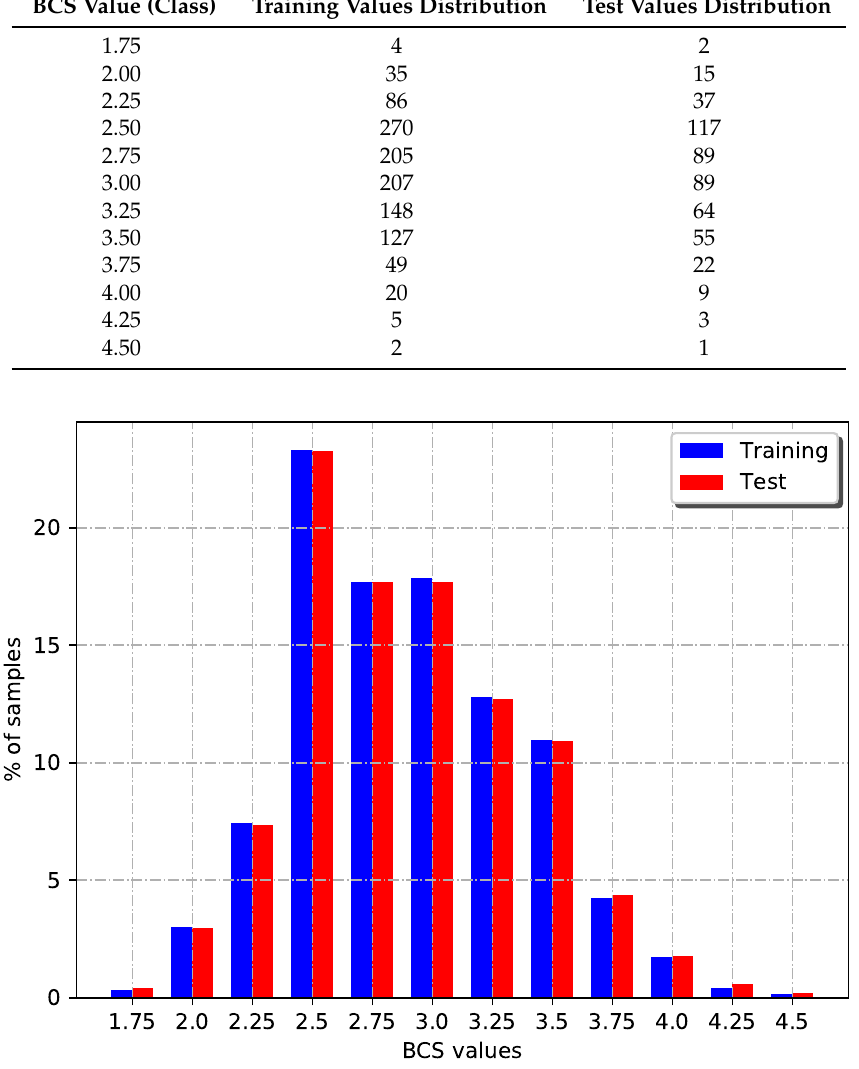
Table 1. BCS values distribution over training and test set.